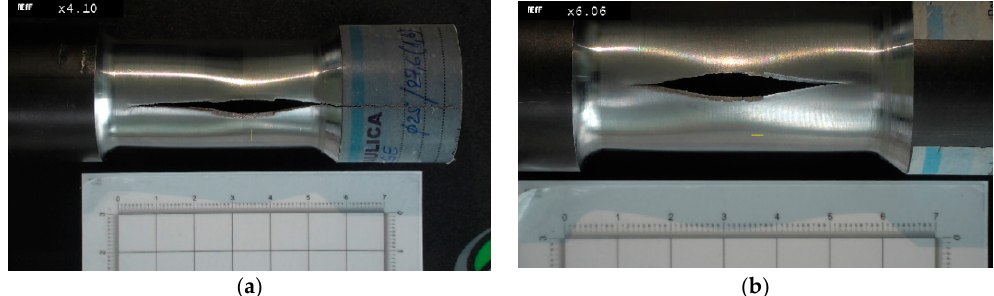
Figure 7. Rupture of pipe specimens due to internal pressure. ( a ) Sample 8; ( b ) Sample 9.